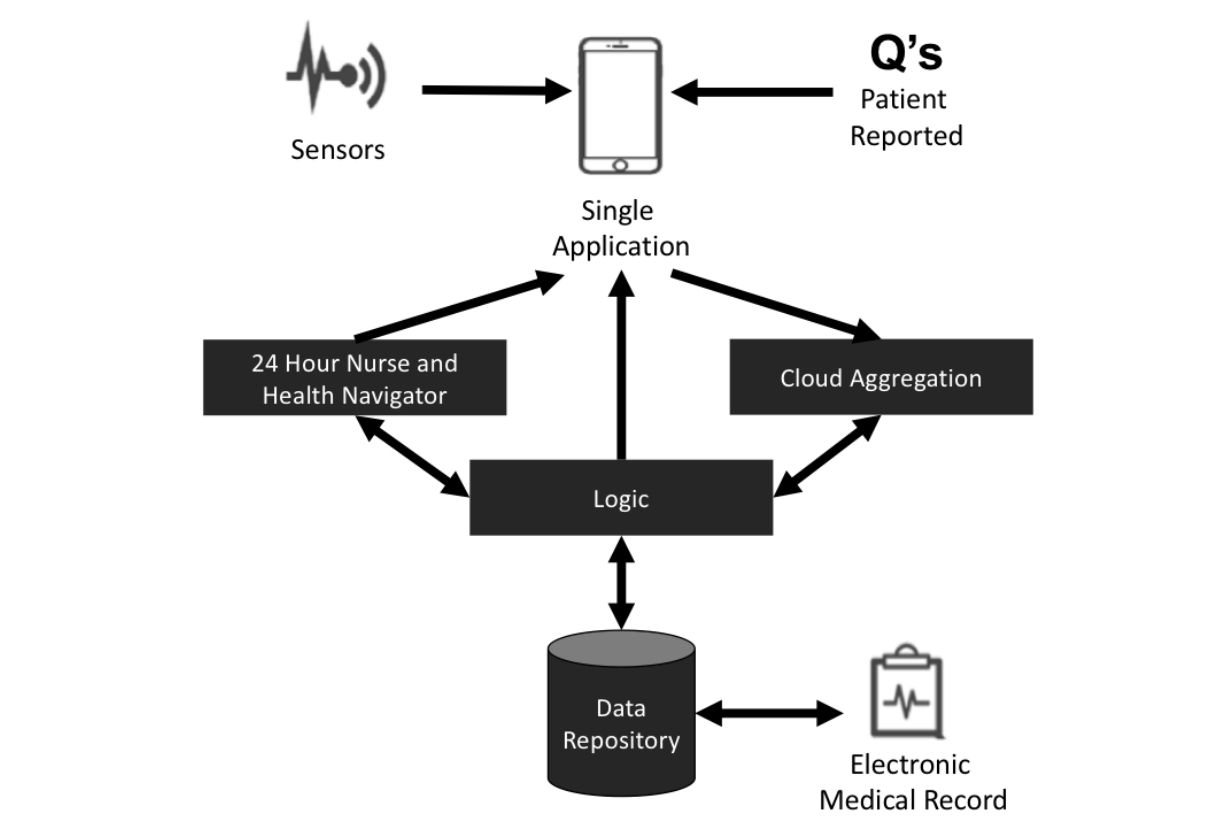
Figure 1. Architecture of ImagineCare care